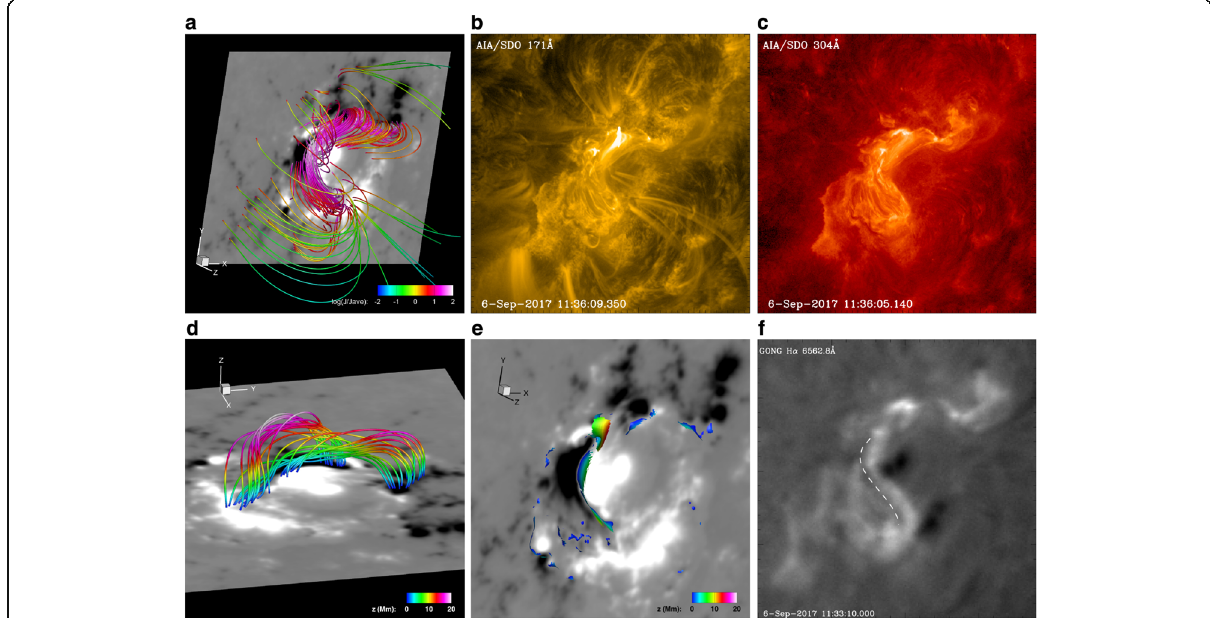
Fig. 15 Comparison of the reconstructed magnetic field with the observed features of the solar corona prior to the flare. a SDO view of sampled magnetic field lines of the CESE-MHD-NLFFF reconstruction. b and c SDO/AIA 171 Å and 304 Å images of the pre-flare corona. d The low-lying magnetic field lines in the core region. The field lines are color-coded by the value of height z. e Locations of dips in the magnetic field lines; the color indicates the value of height z. f GONG H α image of the active region. The dashed curve denotes the location of a long filament (From Jiang et al.